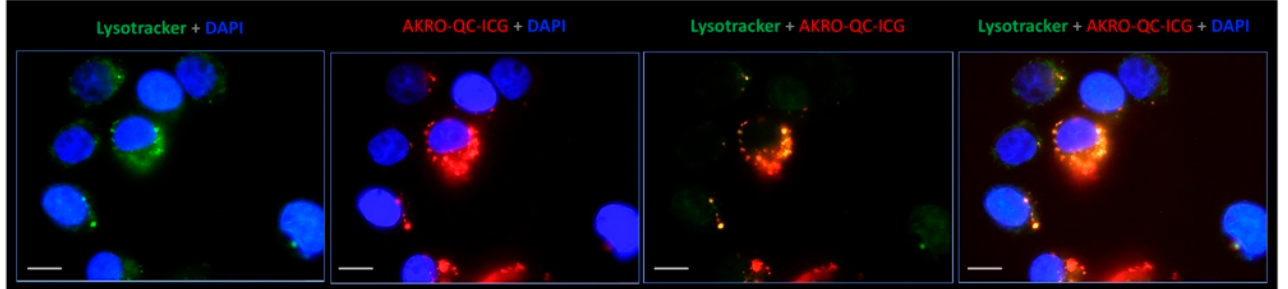
Figure 1. AKRO-QC-ICG accumulates in lysosomes and becomes fluorescent in the human BCa cells in vitro. Representative live cell fluorescence microscopy images of the human breast MDA-MB-486 cancer cell monolayer incubated for 30 min with 1 μ M of quenched substrates followed by washout. ICG fluorescence of probe is false-colored red, lysotracker (lysosome selective stain) is false colored green, blue is DAPI (nuclear stain), and yellow/orange corresponds to lysosome/ICG co-localization. Magnification—100× with immersion (Leica-DM4000B). Scale bar—10 μ m.